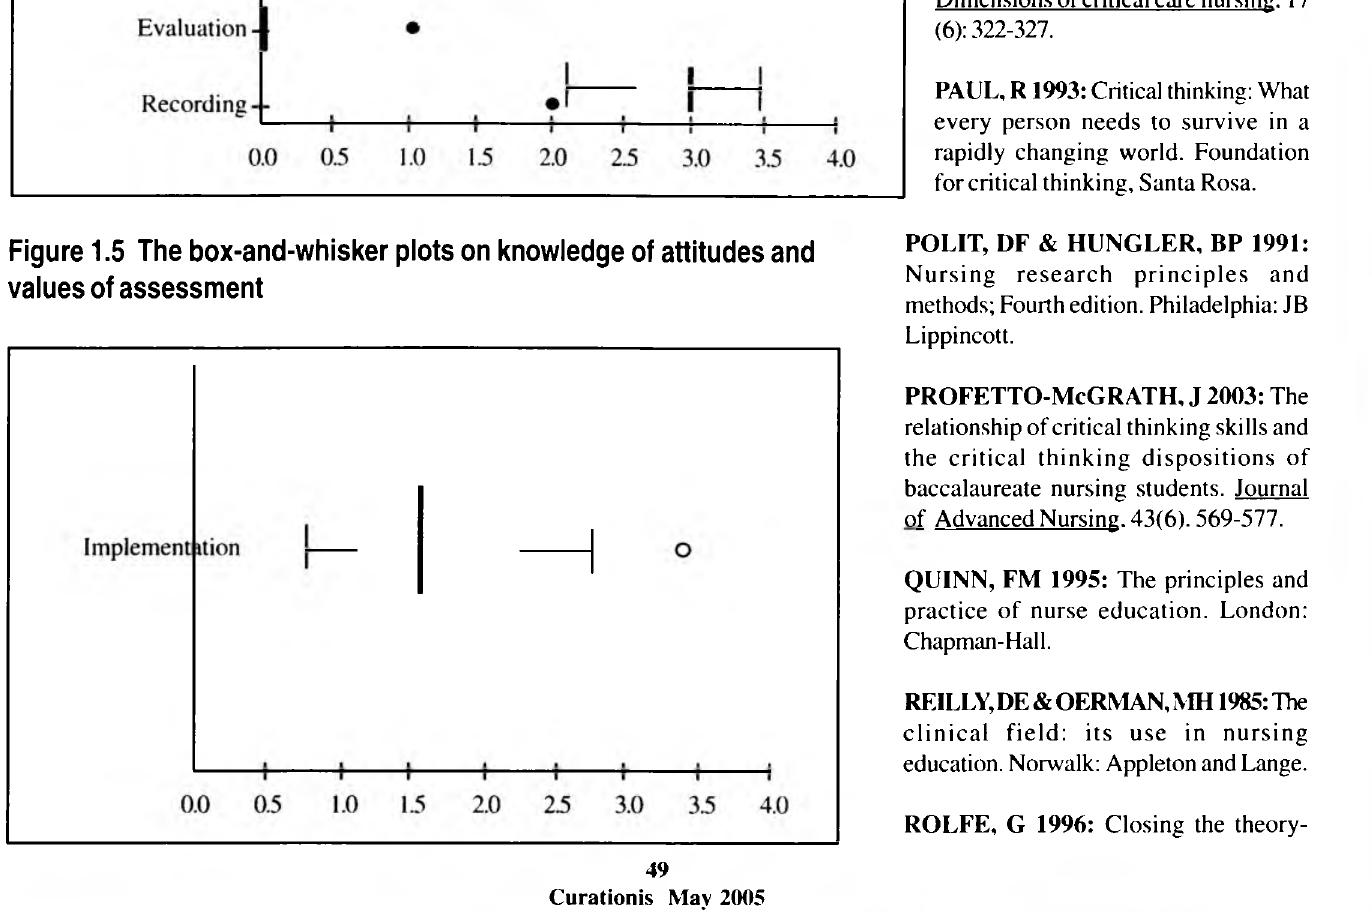
Figure 1.4 The box-and-whisker plots of skills of assessment, diagnosis, planning, implementation, evaluation and recording